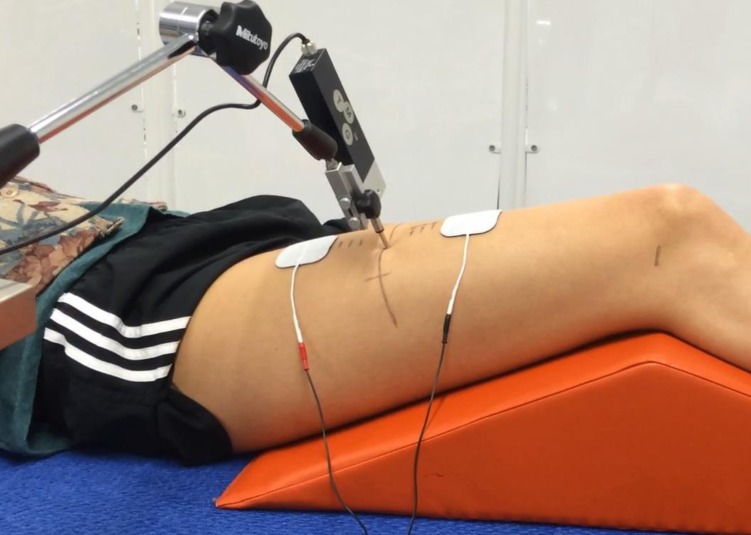
Tensiomyography set-up for assessment of muscle contractile properties.Knee flexed at 120°, relative to 180° full flexion.